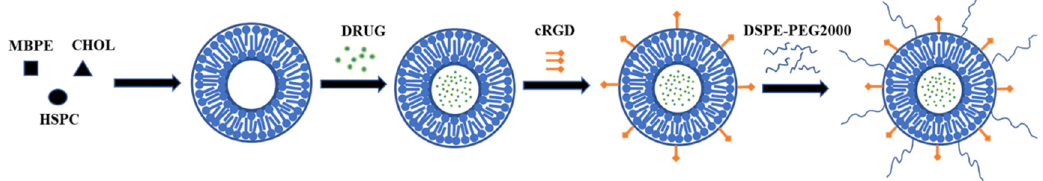
Figure 3. Schematic representation for preparation of RGD-DXRL-PEG.